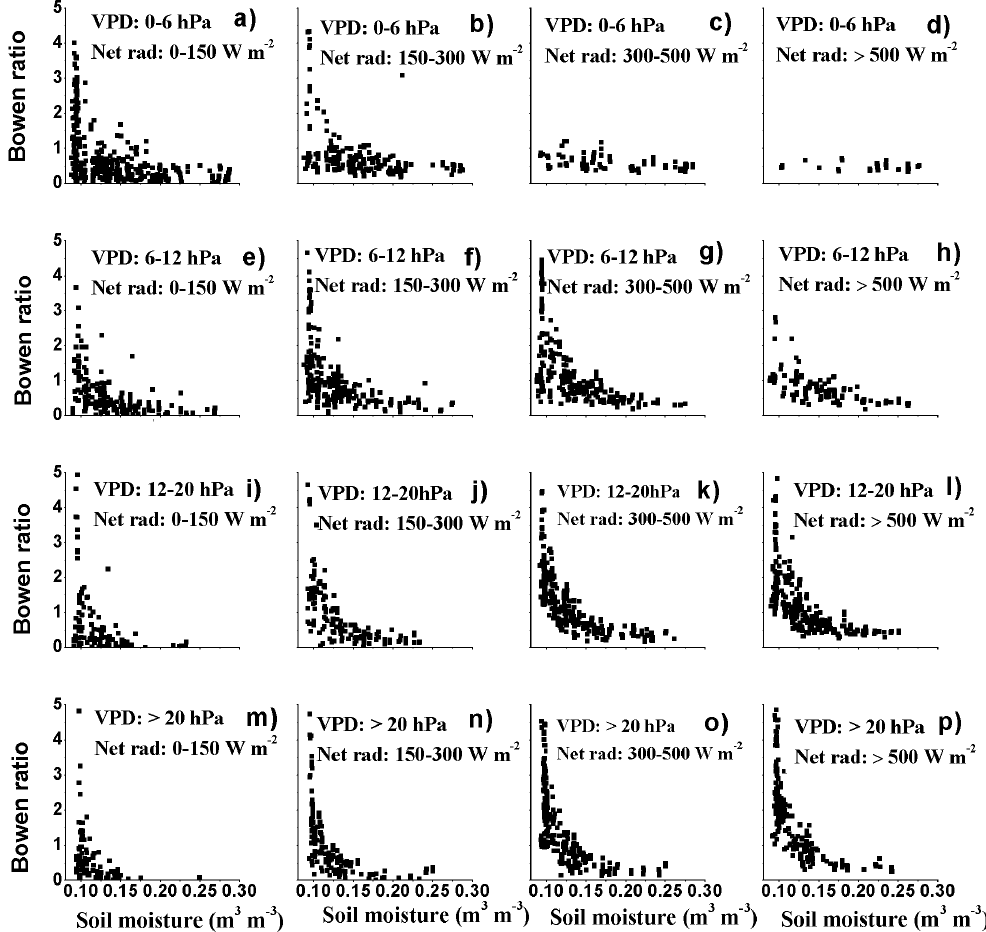
Figure 2. Effects of soil moisture on energy partitioning at different levels of vapor pressure deficit(VPD) (( a – d ) 0–6 hPa, ( e – h ) 6–12 hPa, ( i – l ) 12–20 hPa and ( m – p ) >20 hPa) and net radiation (( a , e , i , m ) 0–150 W m − 2 , ( b , f , j , n ) 150–300 W m − 2 , ( c , g , k , o ) 300–500 W m − 2 , and ( d , h , l , p ) >500 W m − 2 ).